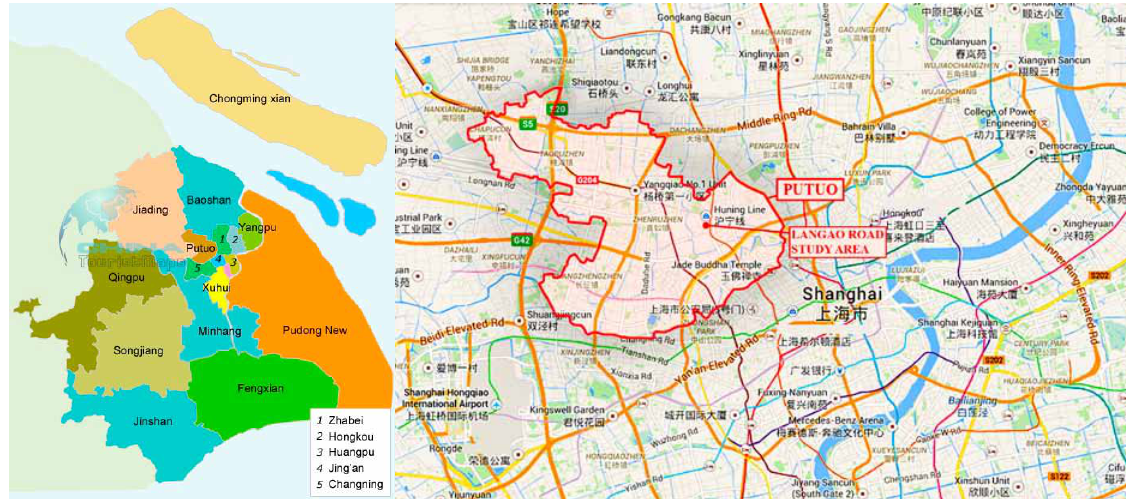
fig. 1. Map of Shanghai that indicates the central location of Putuo district ((left) Shanghai Putuo 2013(right) created by the author according to Map of Shanghai...